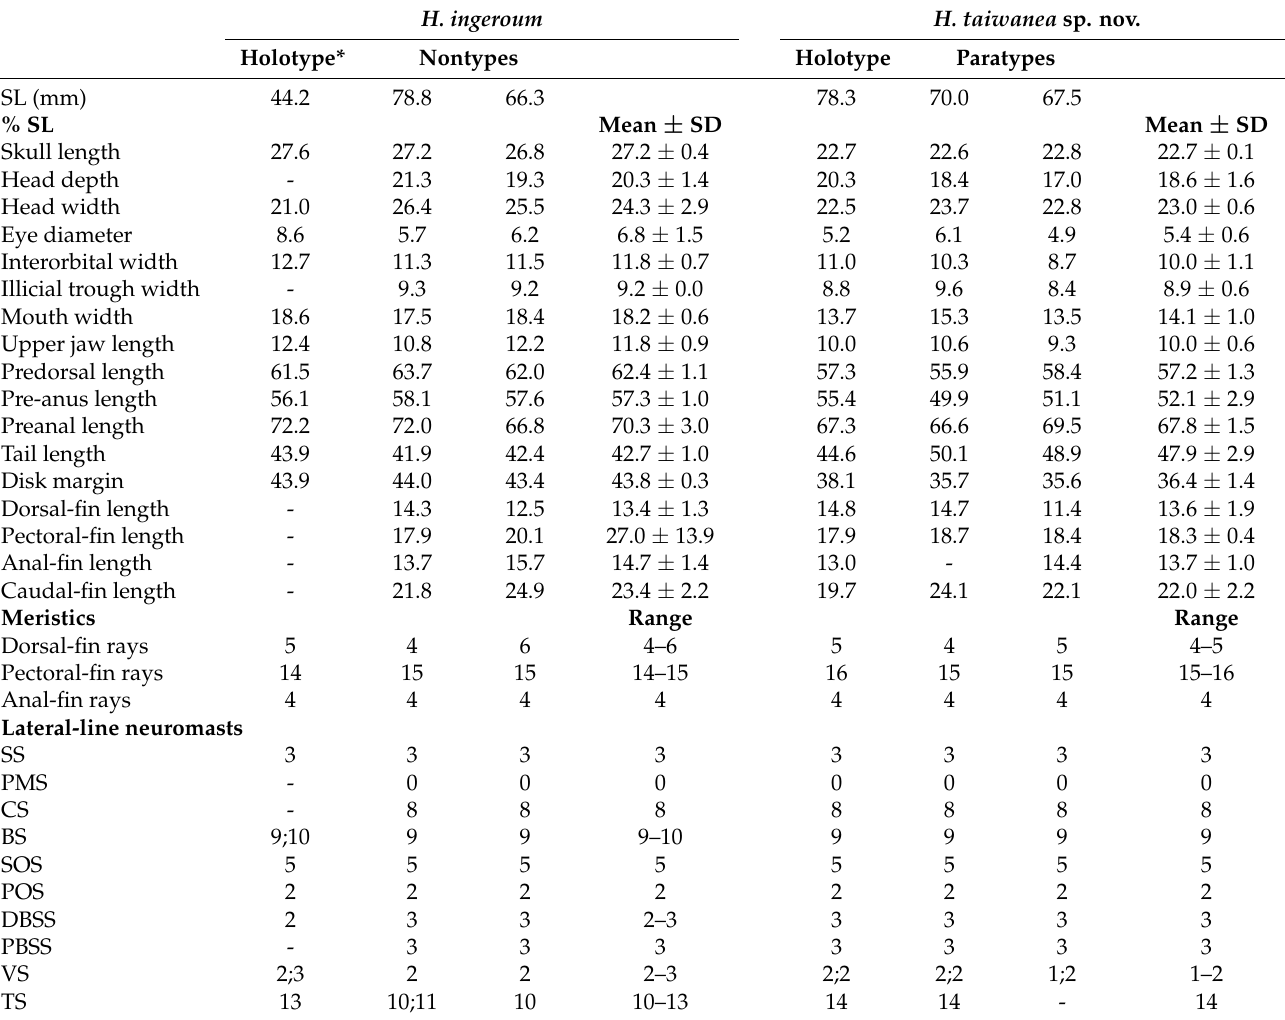
Table 5. Morphometric and meristic data of H. ingeroum and H. taiwanea sp. nov. * data taken